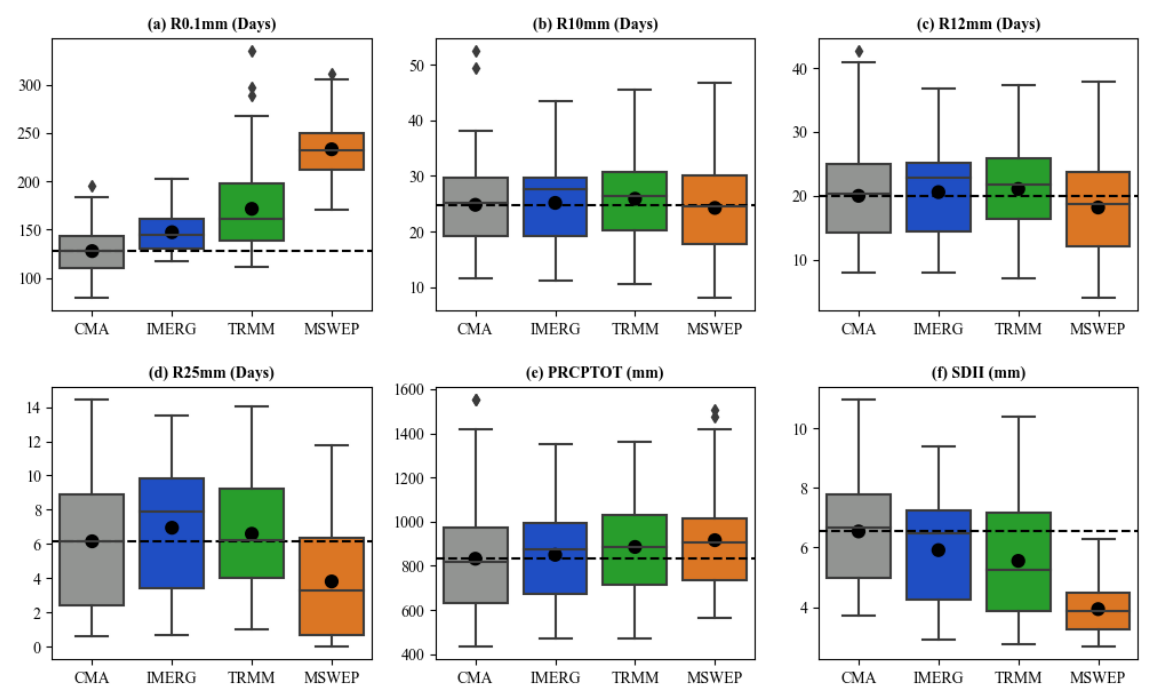
Figure 4. Boxplots for the six absolute threshold indices: ( a ) R0.1mm, ( b ) R10mm, ( c ) R12mm, ( d ) R25mm, ( e ) PRCPTOP, and ( f ) SDII for the observed data and the three products. The upper and lower edges of the box mark the upper and lower quartiles (75% and 25%, respectively). The solid line in the box marks the median value. The uppermost and lowermost horizontal lines mark the 1.5I QR outliers. The point marks the average value. The black dashed line indicates the mean value of the indices of the observed data.